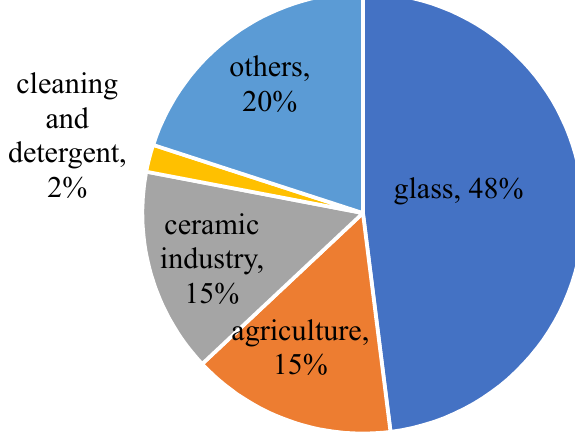
Figure 1. General applications of